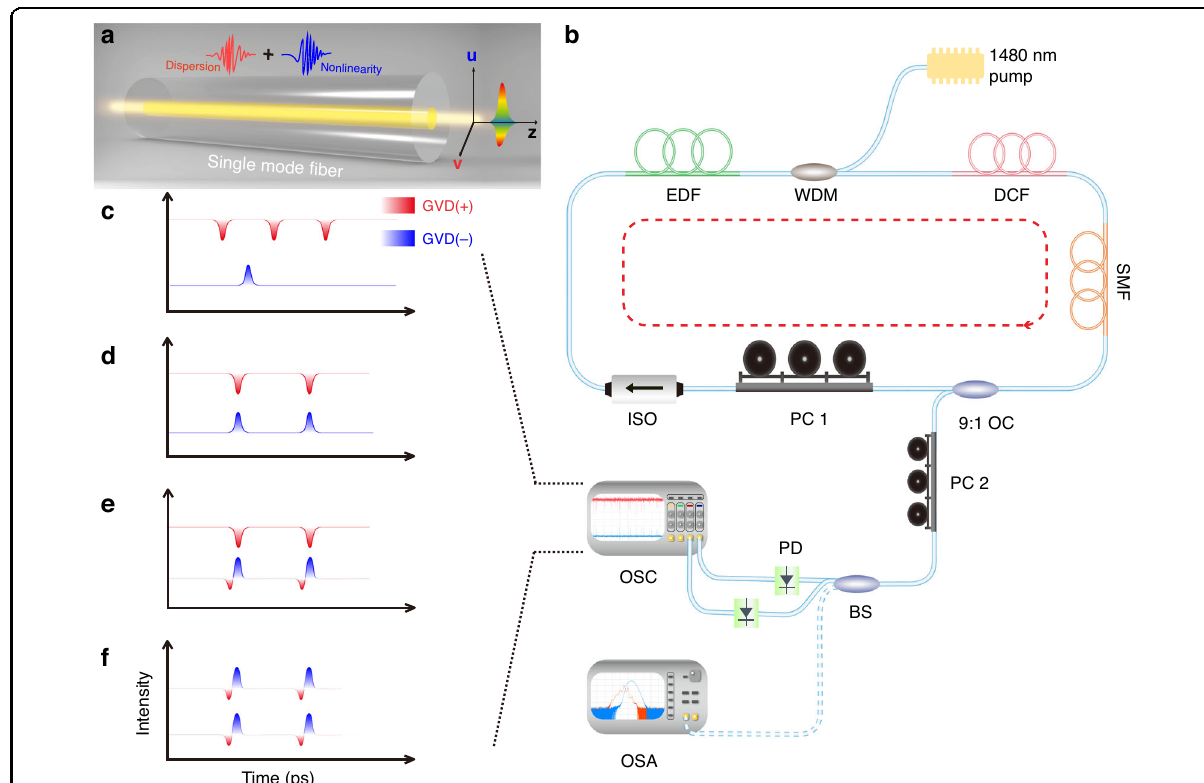
Fig. 1 Schematic of fi ber laser cavity and different soliton operation states. a Illustration of a birefringent single-mode fi ber. b Con fi guration of the fi ber ring laser. c – f Sketch of four typical soliton operation states observed in the experiments. Red color part: DSs formed in the net normal GVD; blue color part: BSs formed in the net anomalous GVD. c Unbound state of DSs and BSs. d State of (1 + 1) PSMs. e State of (2 + 1) PSMs. f State of (2 + 2)